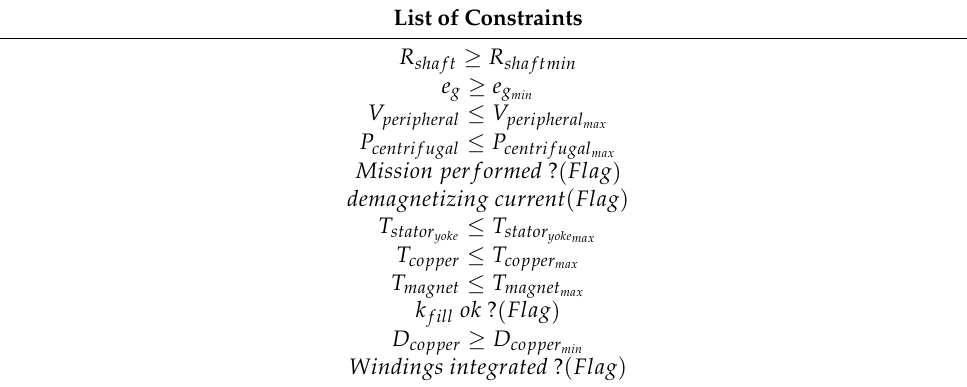
Table 13. List of constraints used in the optimization